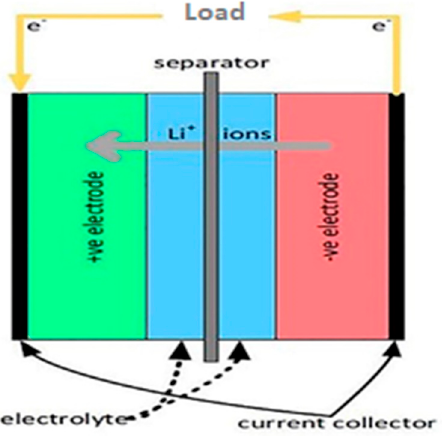
Figure 1. A schematic diagram of a lithium-ion battery (LIB). Adapted from reference [7].